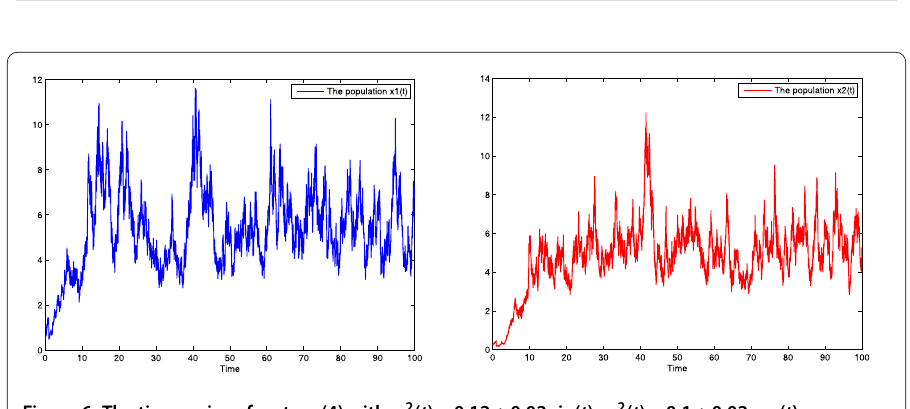
( t ) = 0.12 + 0.02sin( t ), σ 2 1